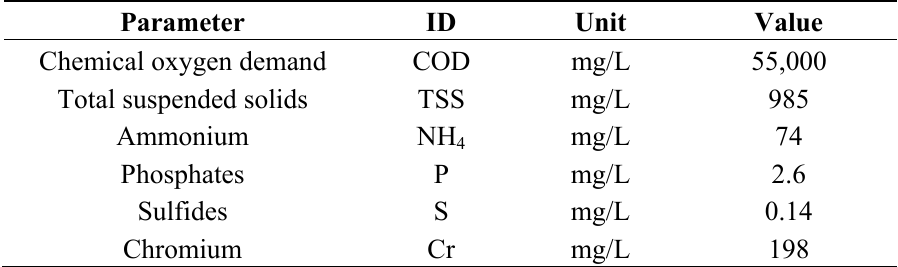
Table 1. Characteristics of the raw tannery wastewater stream.